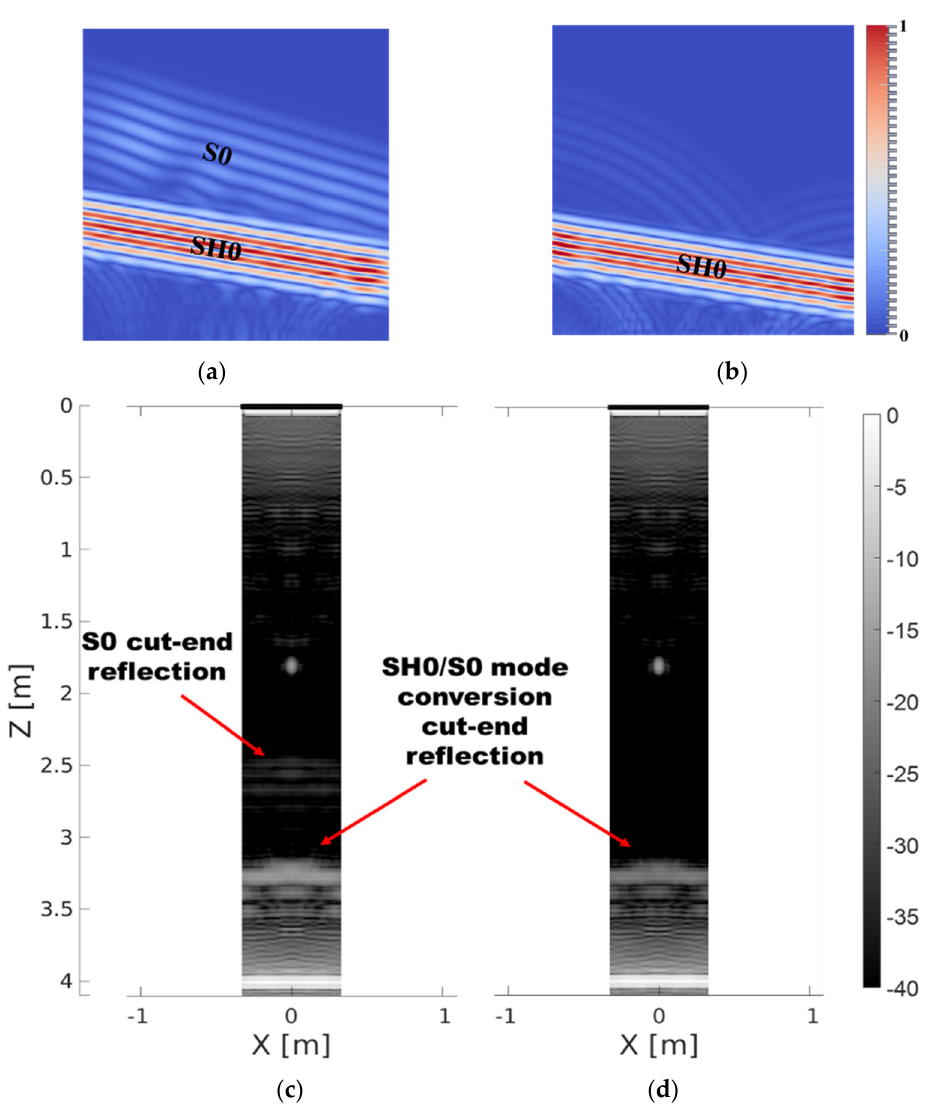
Figure 14. FE comparison of classic ( a , c ) and S0-cancelling ( b , d ) transduction setups. Simulation of transmitted 10° plane waves are illustrated at the top, and PWI reconstructions of pipe with 0.2 λ SH0 , 75% through wall thickness deep crack at 1.8 m axial distance from the array are presented at the bottom. All four images are in the form of unwrapped pipe.